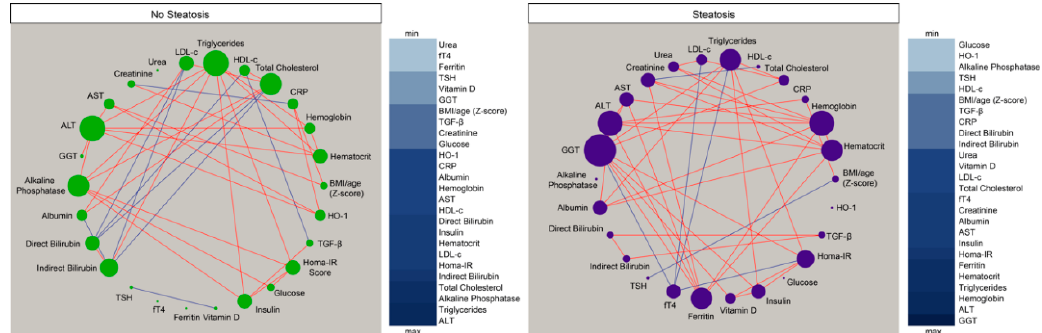
Figure 2. Hepatic steatosis leads consistent changes in correlations between plasma proteins concentrations. Network analysis of the biomarker correlation matrices was performed with bootstrap (100 × ). Significant correlations ( p < 0.05) are shown. Each circle represents a di ff erent parameter. Circle size infers number of correlations involving each parameter. Lines represent the rho values. Red color infers positive correlation whereas blue color denotes negative correlations. Node analysis heatmap shows the number of statistically significant correlations involving each marker per clinical